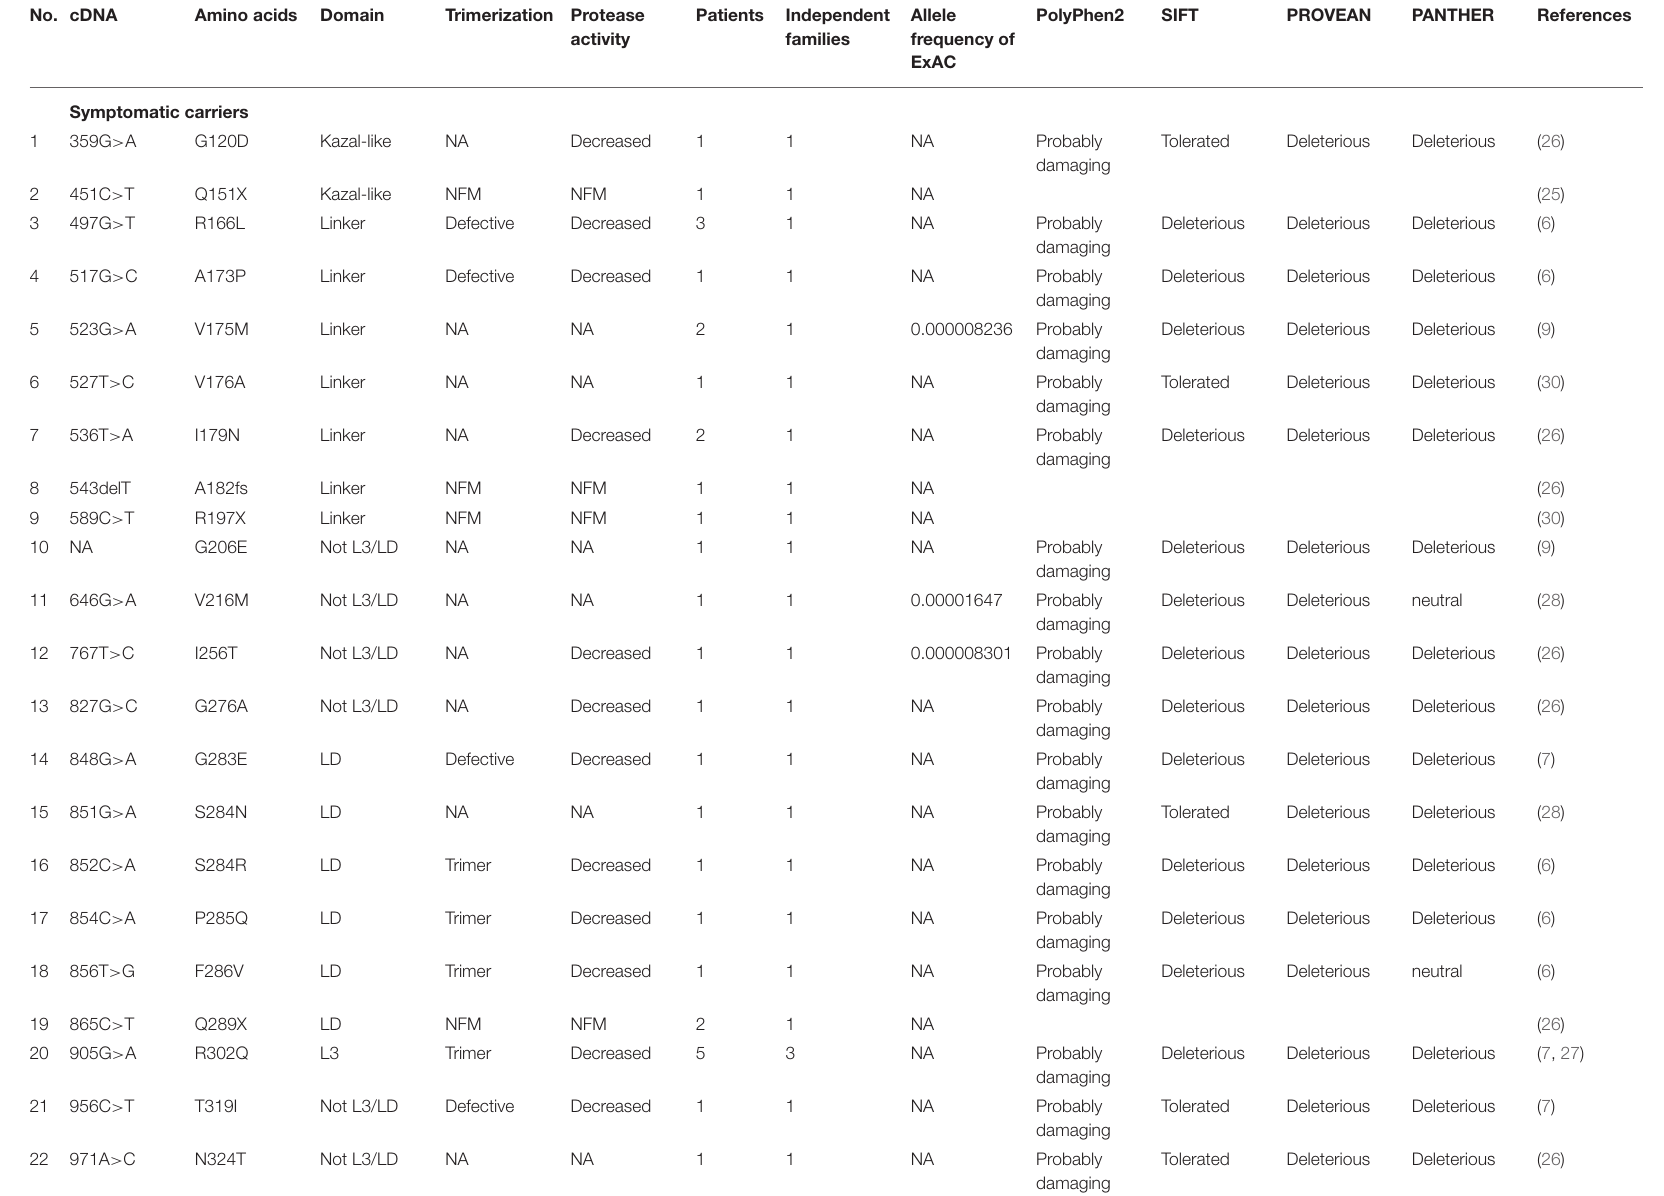
TABLE 1 | Summary of mutations identified in patients with HTRA1 -related